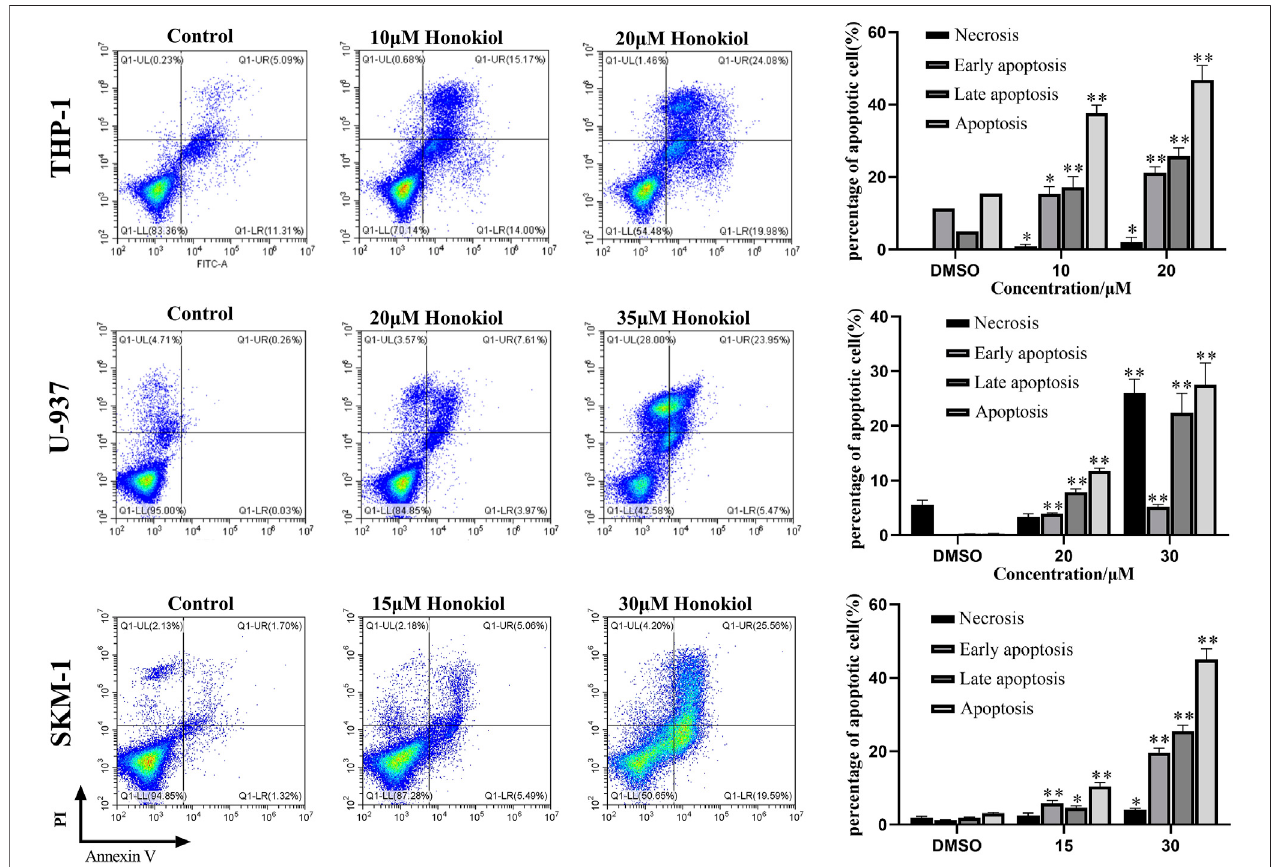
FIGURE2| Effects ofhonokiolontheapoptosisofTHP-1,U-937,andSKM-1cells.Thecellswereincubatedwiththeindicatedconcentrationofhonokiolfor24 h, and Annexin-V-FITC/PI staining and fl ow cytometry analysis were performed. The experiments were performed in triplicate. Statistical analysis of cell apoptosis was shown as bar graphs (*, p < 0.05, **, p < 0.01, compared to the control